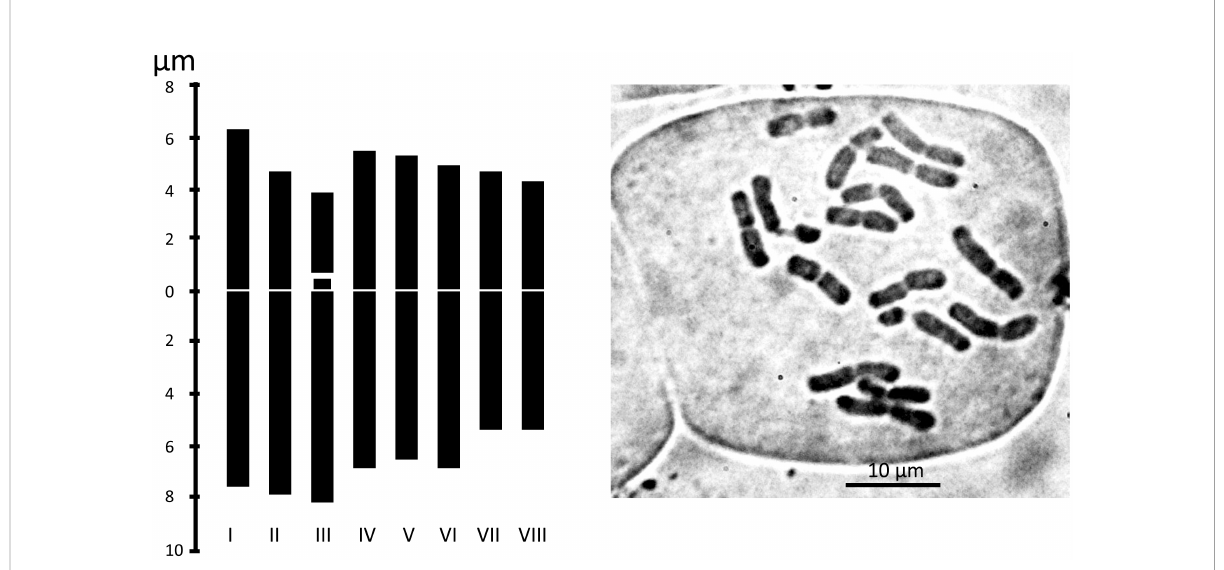
FIGURE 6 Metaphase plates and Idiograms of Allium sulaimanicum (Am1301). For the origin of the accession, see the Table